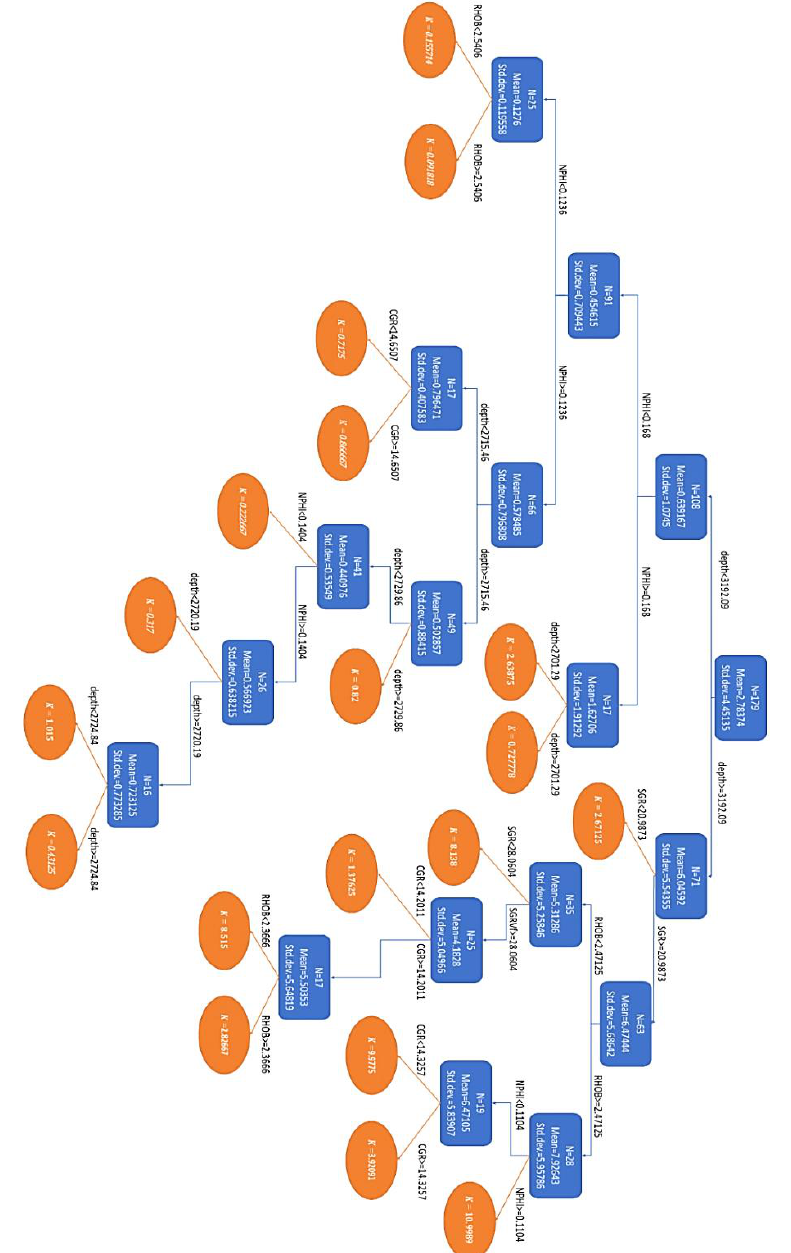
Figure 5. Regression tree for permeability prediction with statistical parameters of nodes and splitting